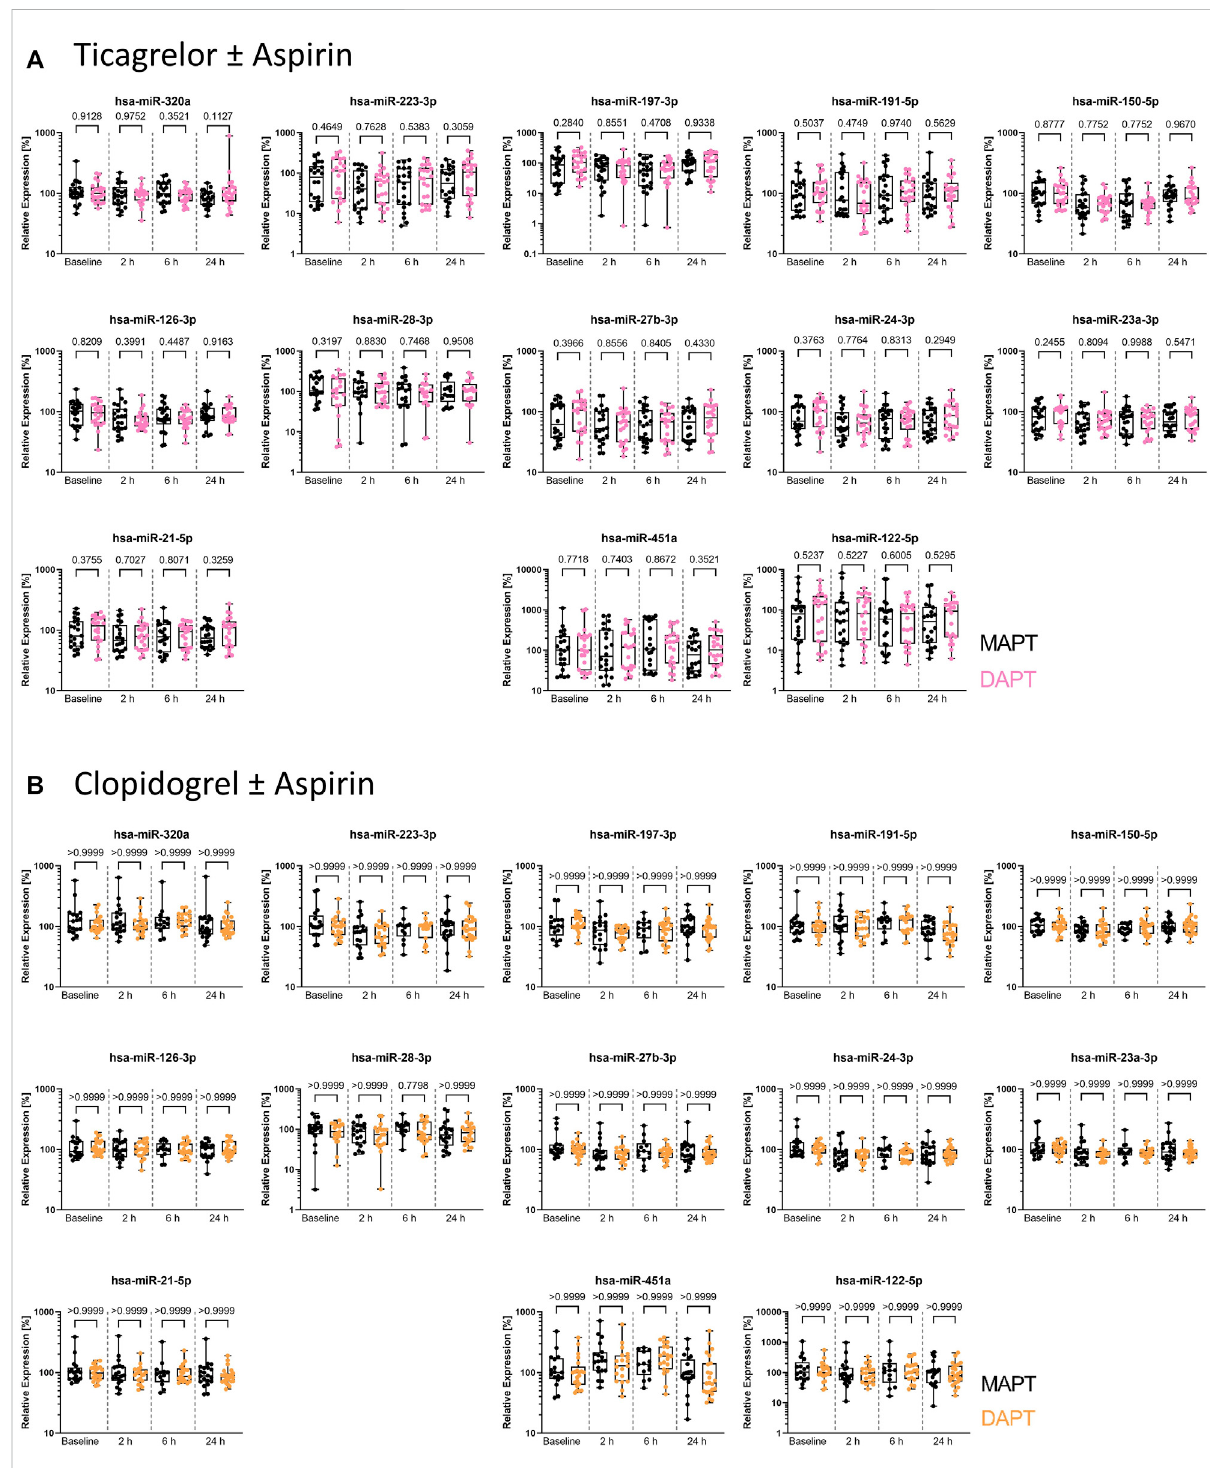
FIGURE 1 PlasmalevelsofmiRNAsfromthethrombomiRpanelarenotaffectedbyadditionofaspirintoP2Y12inhibitors,warrantingcombinedanalysisof MAPT and DAPT data. (A) MiRNA levels in subjects treated with ticagrelor and aspirin or placebo (independent donors MAPT = 22; independent donors DAPT = 22). (B) MiRNA levels in subjects treated with clopidogrel and aspirin or placebo (independent donors MAPT = 20; independent donors DAPT = 23). Values represent the relative expression of UniSp4 normalized Cq values that were linearized ( ΔΔ Cq, % of the median of baseline samples). Kruskal-Wallis test with Dunn ’ s multiple comparisons test was calculated. p -values < 0.05 were considered signi fi